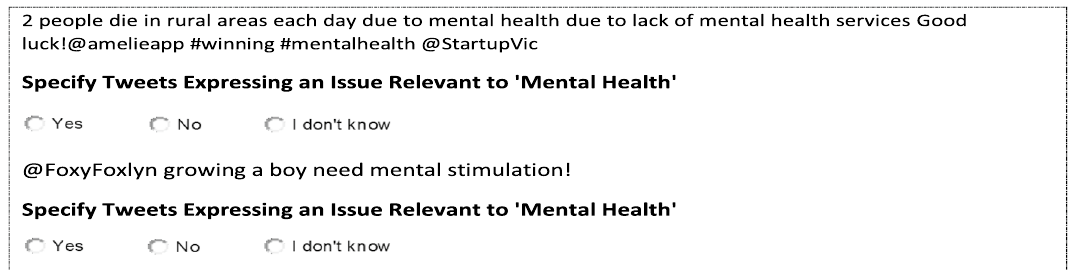
Fig. 4 Sample of questions to workers to verify the tag of